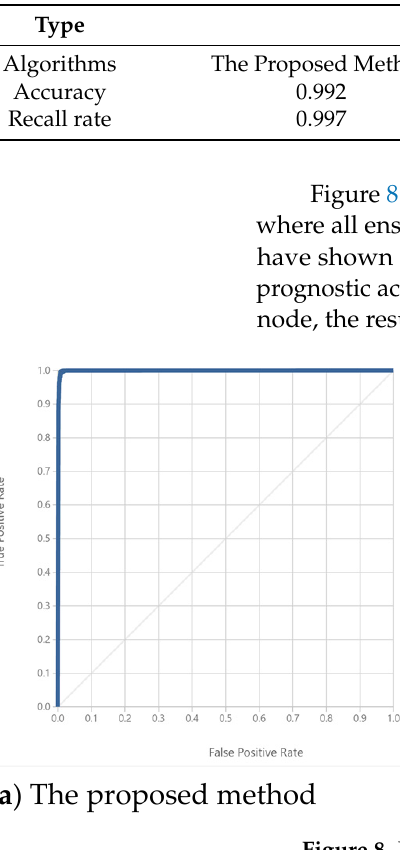
Figure 8. ROC curve of the blister packing machine case.